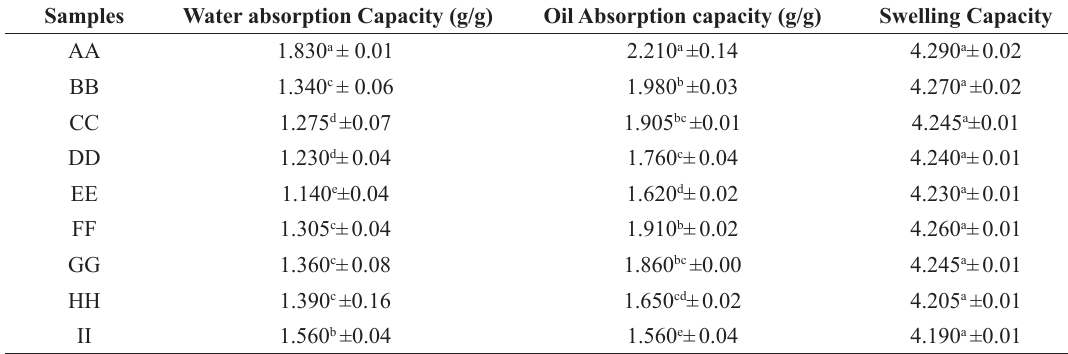
Mean ±SD of three replicates Values in the same column with different superscript are significantly different (P<0.05) Maize: roasted Groundnut Ratio- AA-(100%Maize), BB-(90:10), CC-(80:20), DD-(70:30), EE-(60:40). Maize: boiled Groundnut